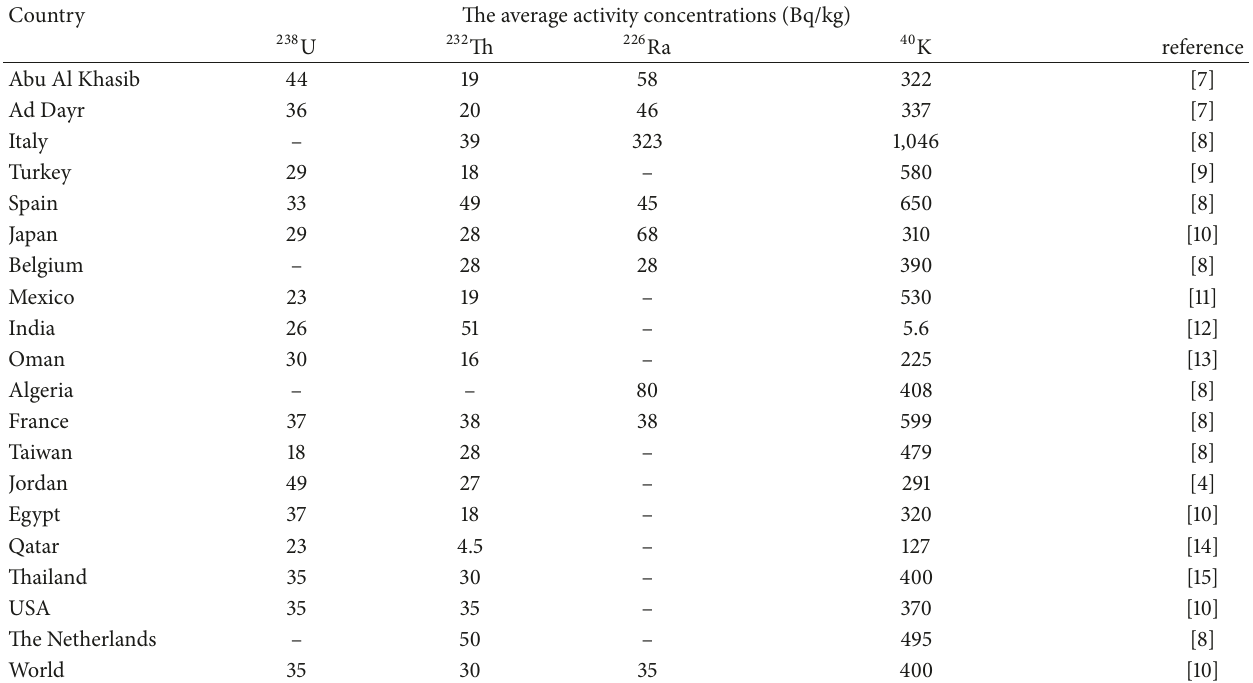
Table 5: The average activity concentrations of 238 U, 232 Th, 226 Ra, and 40 K radionuclides in Bq/kg evaluated by R. S. Mohammed and R. S. Ahmed [7], compared with different countries and worldwide average.